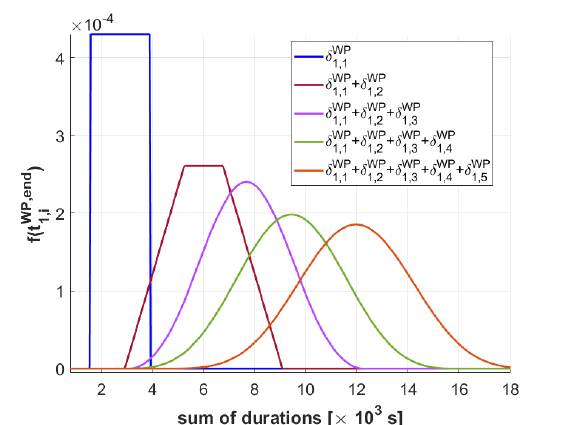
Figure 4. Probability distribution of the sum of durations of tasks, which are uniform distributed random variables of ( m , u ): (3132, 791), (4368, 1012), (2876, 698), (3856, 971), (4112, δ WP h , i δ WP h , i